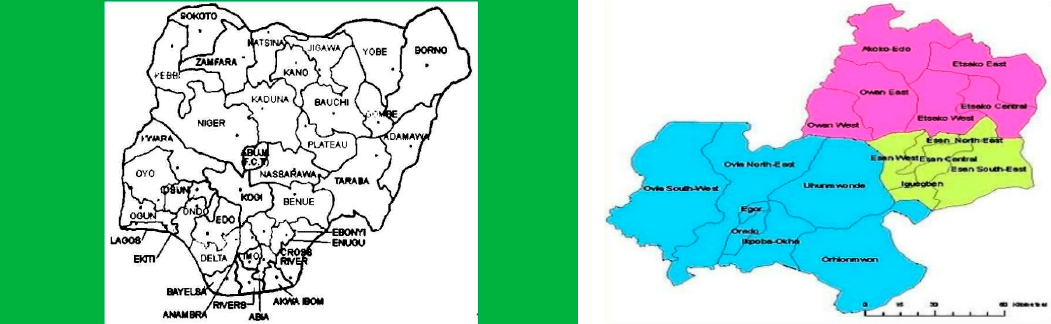
Figure 1. Map of Nigeria and Edo State in Nigeria.